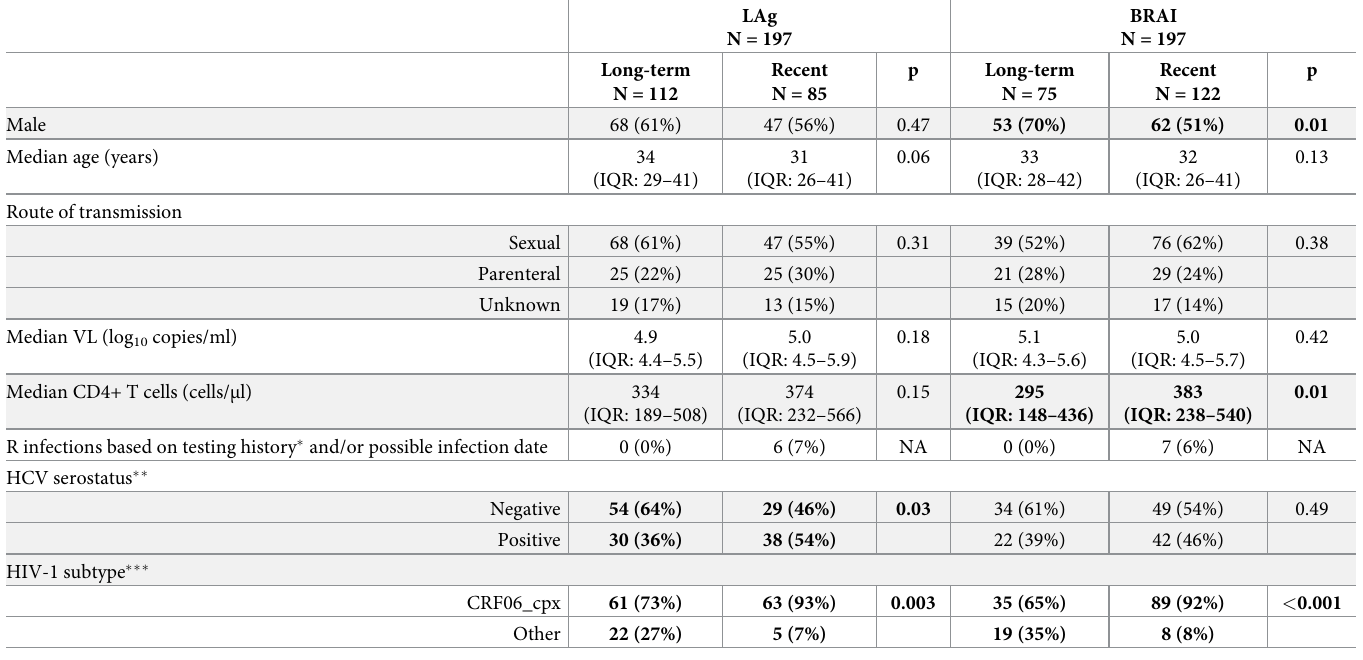
Table 2. Demographic and clinical data of persons with HIV-1 viral loads measured within 6 months after HIV diagnosis classified as long-term or recent by LAg and